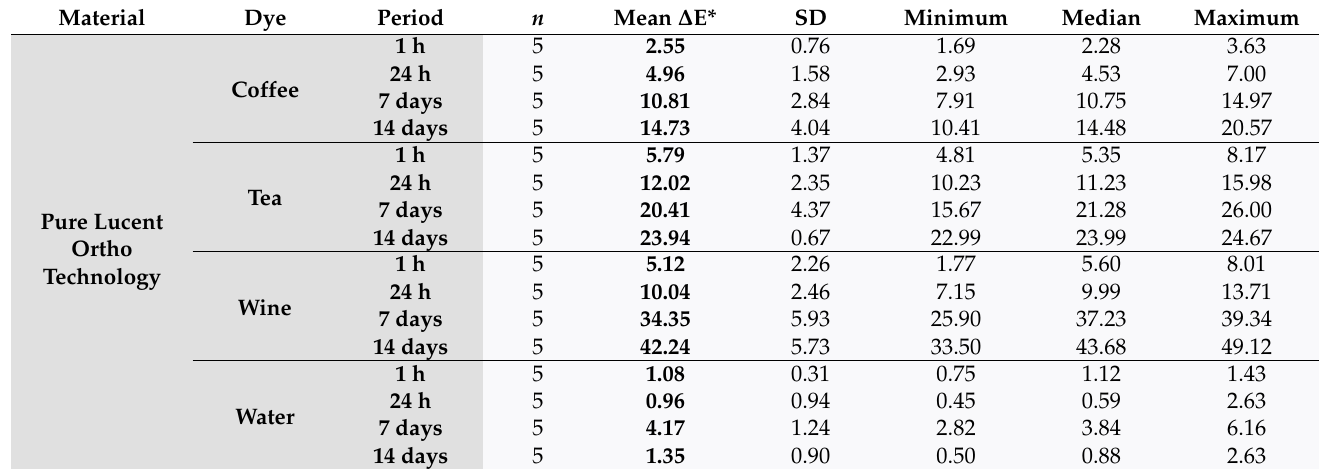
Table 2. Mean color changes of Pure Lucent brackets with respect to incubation time and type of